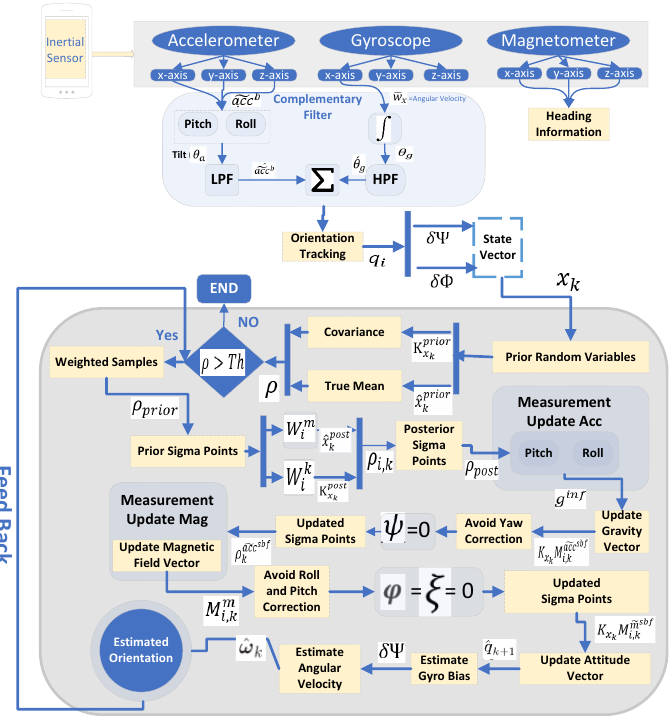
Figure 3. Orientation Estimation Based on